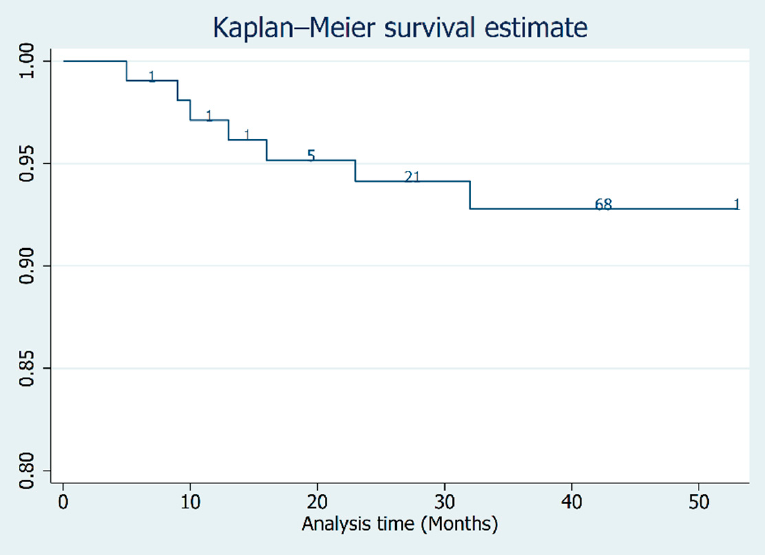
Figure 4. The Kaplan–Meier curve of the entire sample; the number of patients censored at each follow-up are reported in the graph. Seven restorations did not provide a successful outcome; six unsuccessful restorations were located in the posterior region.